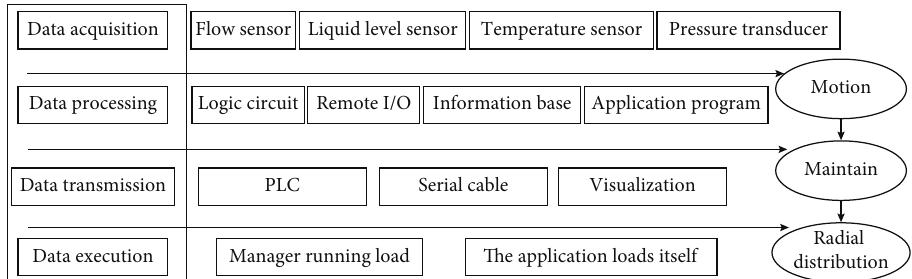
Figure 1: Structure of automation control technology for electrical